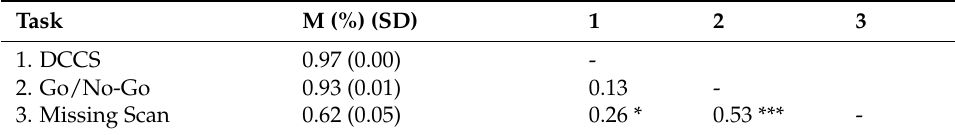
Table 1. Mean ( SD ) of Accuracy in Each Task and their Correlations. Task M (%) (SD) 1 2